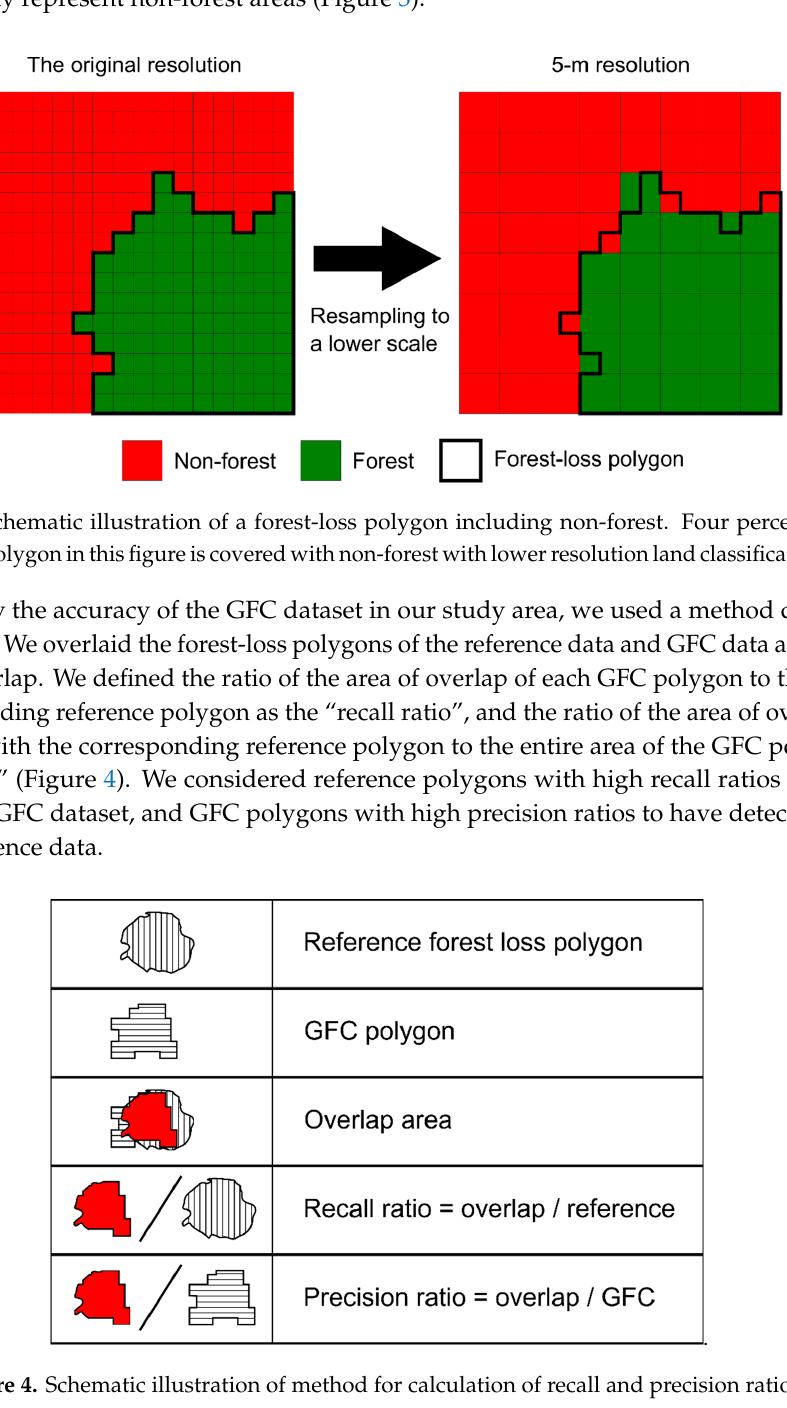
Figure 4. Schematic illustration of method for calculation of recall and precision ratios.